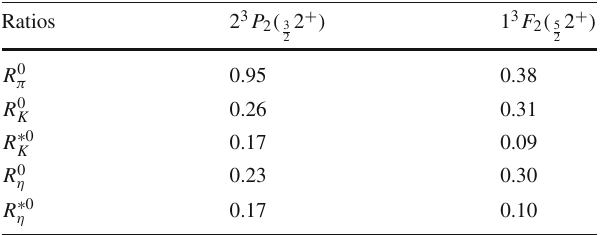
Table 13 Various ratios for the two different identification of the state ( 3000 D ∗ 2